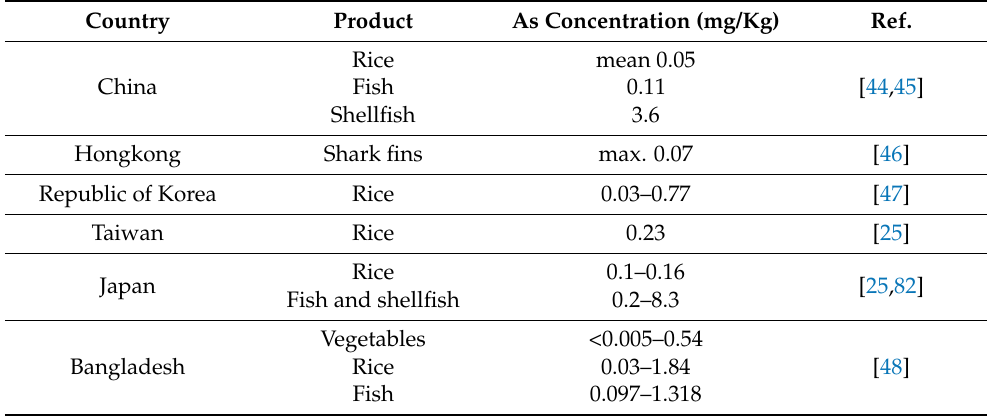
Table 2. Foods affected by arsenic contamination in Asia regions (selected data from recent